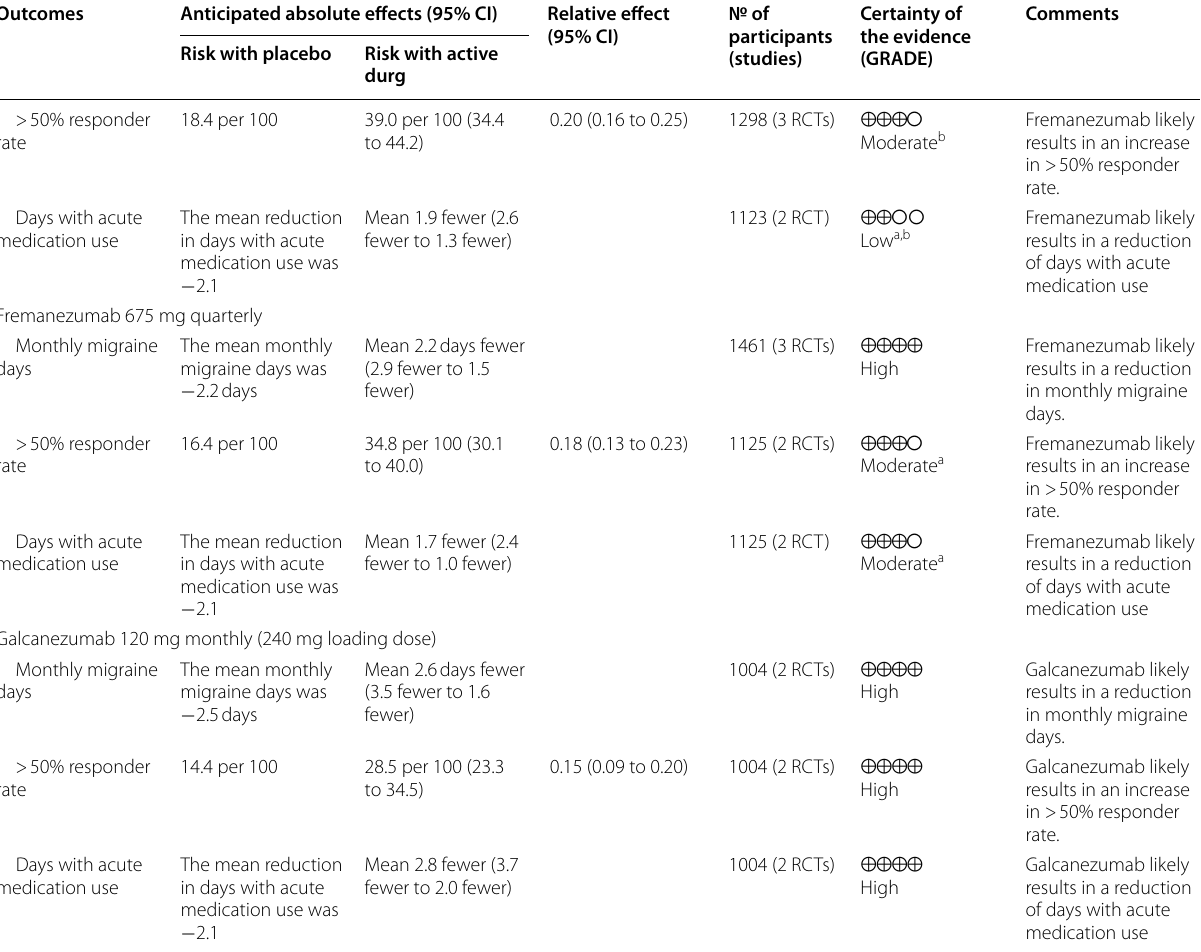
Table 7 Randomized controlled clinical trials in individuals with migraine comparing a monoclonal antibody targeting the CGRP pathway with another migraine preventive agent Trial Phase Monoclonal